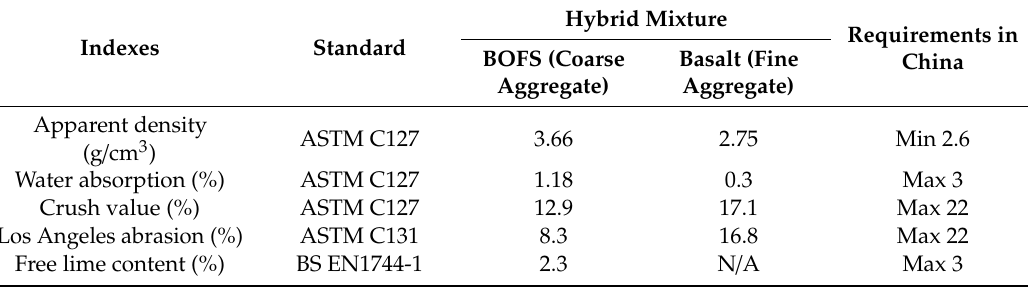
Table 1. Basic properties of BOFS and basalt.